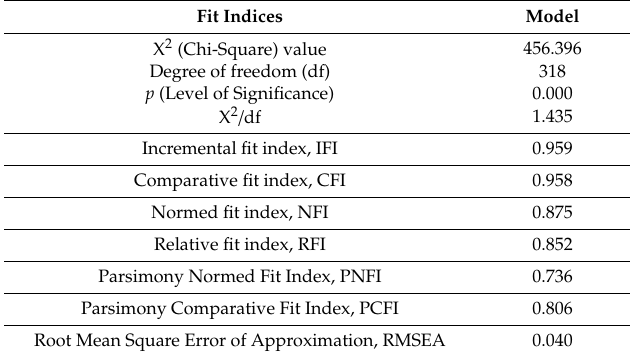
Table 5. The goodness-of-fit results of the